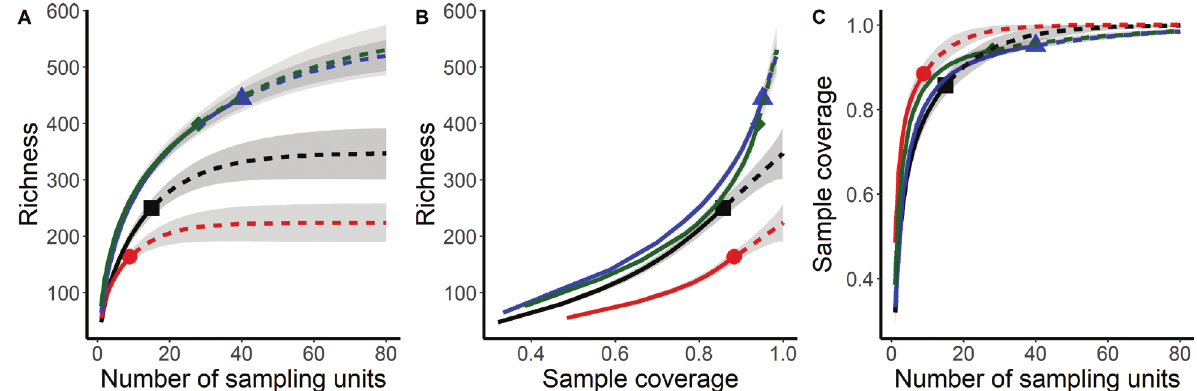
Figure 3. A Sample-size-based; B Coverage-based rarefaction and extrapolation sampling curves for species rich- ness; C Sample completeness curves for each vegetation type. Solid line segments indicate rarefaction and dotted line segments indicate extrapolation (up to a maximum sample size of 40), while shaded areas indicate 95% confi- dence intervals (based on a bootstrap method with 100 replications). Colours and symbols: black square, 1.1 Celtis tala / Sida rhombifolia closed forest; red circle, 1.2 Aspidosperma quebracho-blanco / Prosopis kuntzei open forest; blue triangle, 2.1 Jarava pseudoichu / Vachellia caven open savanna; green diamond, 2.2 Acalypha variabilis / Nassella cor- dobensis